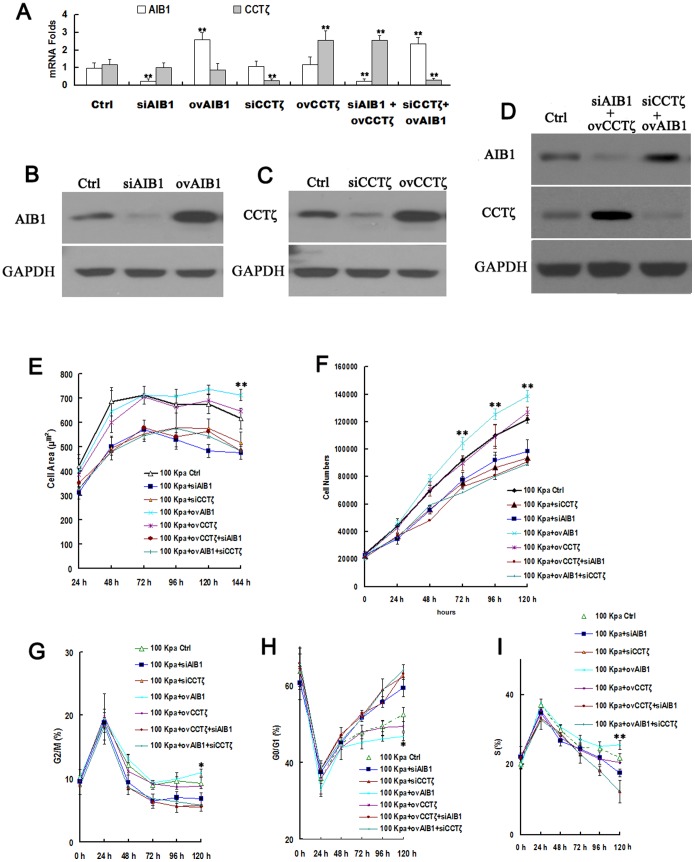
Effects of the overexpression and/or knock-down of AIB1 and/or CCTζ on the cell proliferation, spreading area, and cell cycle of breast cancer MCF-7 cells grown on silicone substrates with EY = 100 kPa (**P<0.01).(A) The mRNA expression levels of AIB1 and CCTζ in control, siAIB1, ovAIB1, siCCTζ, ovCCTζ, siAIB1+ovCCTζ, and siCCTζ+ovAIB1 MCF-7 cell groups were validated by real-time RT-PCR, **P<0.01, compared with control cells. (B) The expression of AIB1 in the siAIB1 and ovAIB1 MCF-7 cell was validated by Western Blot. (C) The expression of CCTζ in the siCCTζ and ovCCTζ MCF-7 cells was validated by Western Blot. (D) The expression of AIB1 and CCTζ in the siAIB1+ovCCTζ and siCCTζ+ovAIB1 MCF-7 cells was validated by Western Blot. (E) The spreading area of all Cell types (control, si-AIB1, si-CCTζ, ovAIB1, ovCCTζ, si-AIB1+ovCCTζ, and siCCTζ+ovAIB1) grown on silicone substrates with EY = 100 kPa. **P<0.01. (F) Growth curves of all cells (control, siAIB1, siCCTζ, ovAIB1, ovCCTζ, siAIB1+ovCCTζ, and siCCTζ+ovAIB1) grown on silicone substrates with EY = 100 kPa. **P<0.01. G2/M phase (G), G0/G1 phase (H), and S phase (I) of the cell cycle was assessed in cells (control, si-AIB1, siCCTζ, ovAIB1, ovCCTζ, siAIB1+ovCCTζ, and siCCTζ+ovAIB1) grown on silicone substrates with EY = 100 kPa. **P<0.01 compared with si-AIB1.